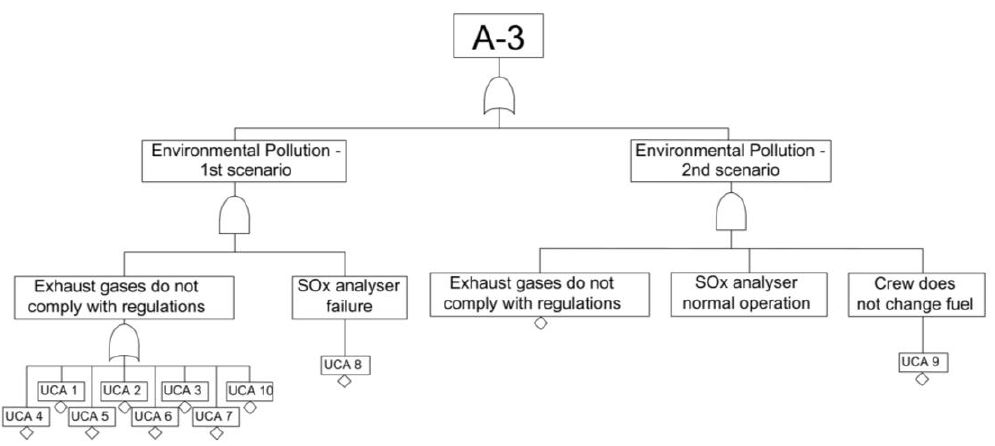
Figure 10. Fault Tree populated with STPA results (Step 6).